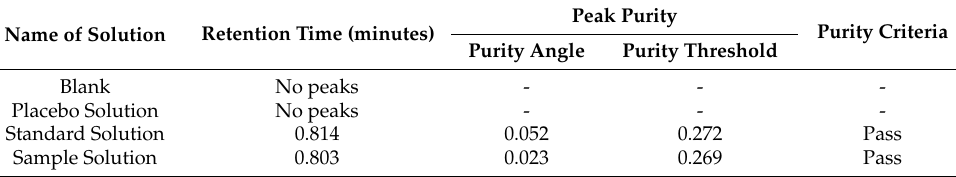
Table 3. Results of Selectivity Study.